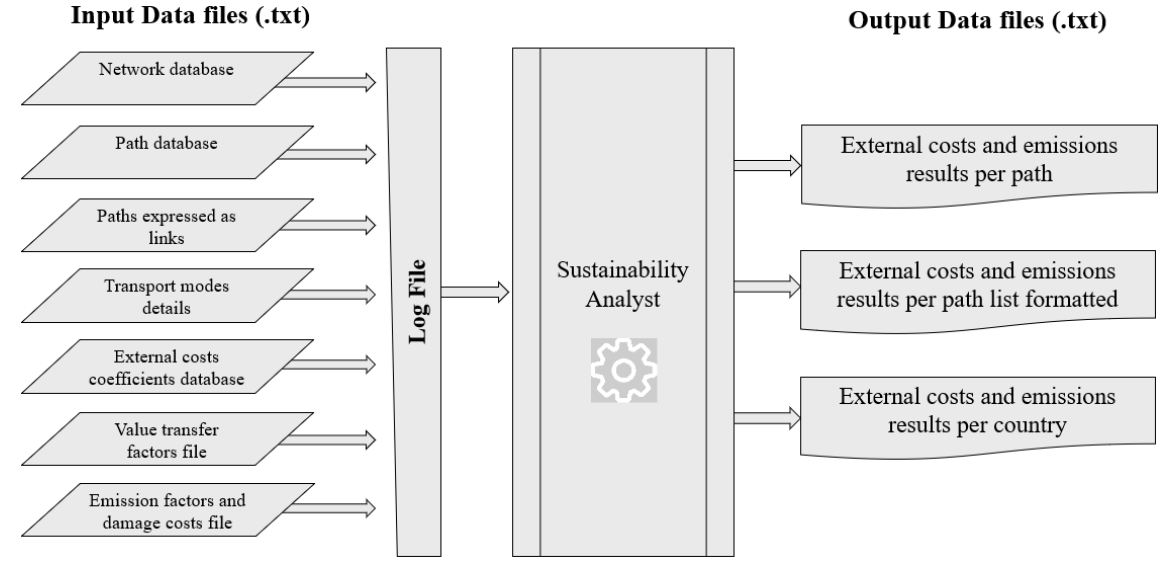
Figure 1. Data flowchart of the software Sustainability